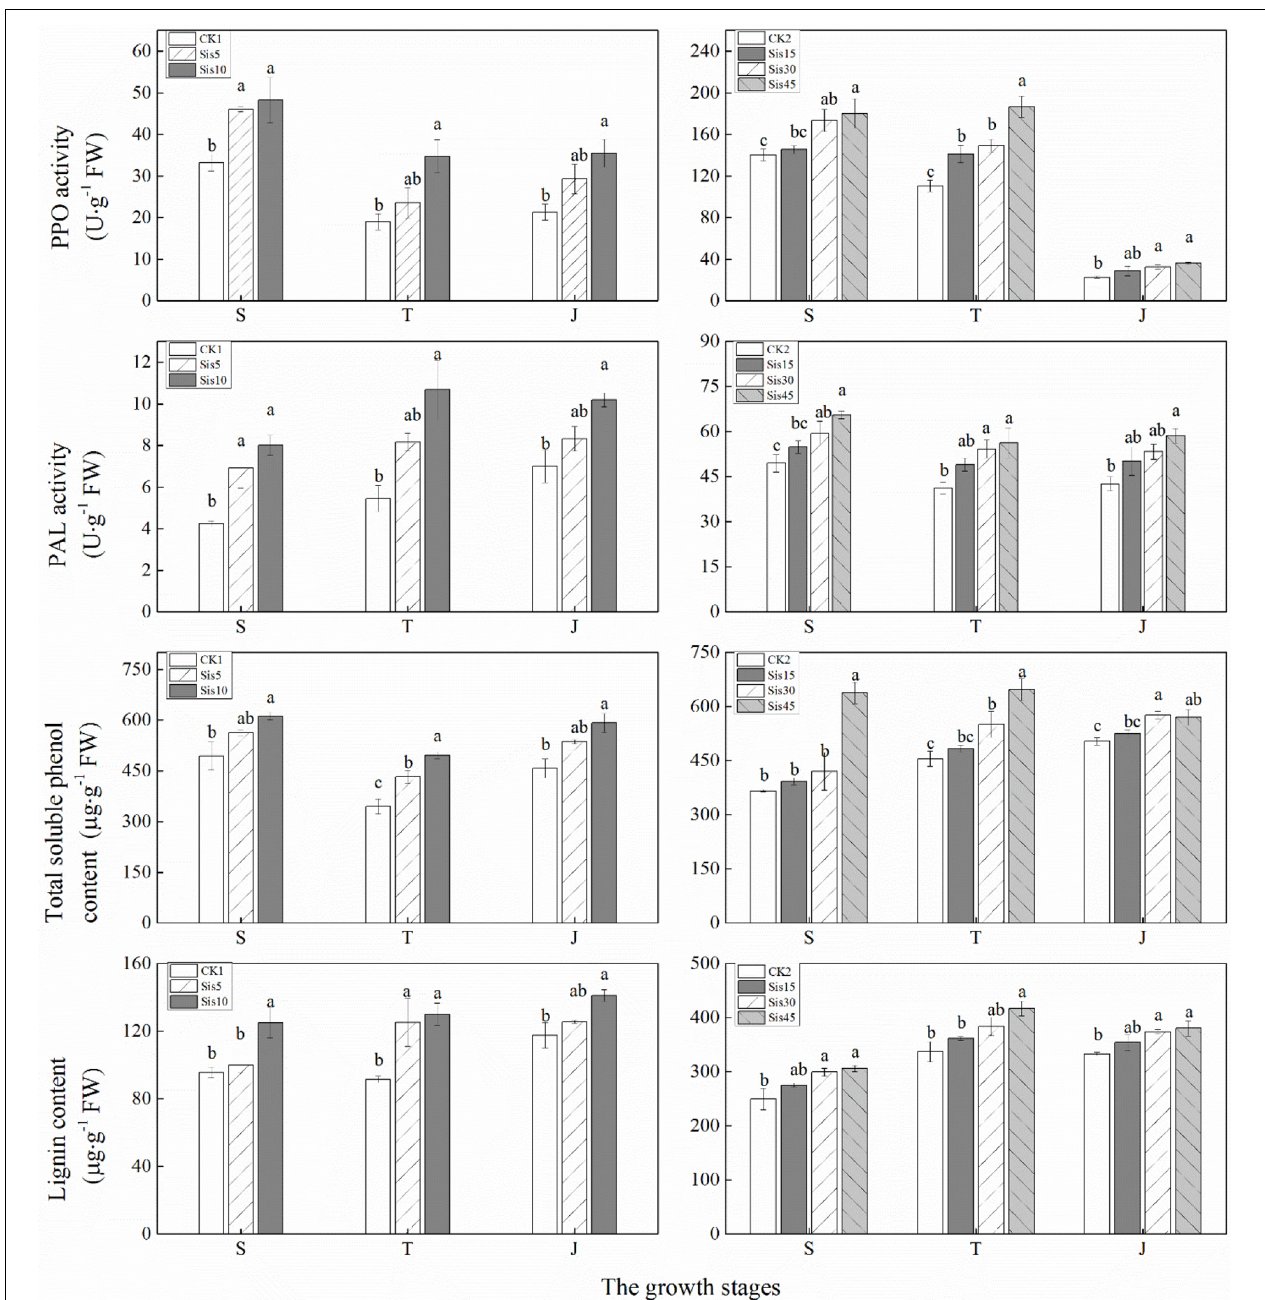
FIGURE 4 | Effects of silicon application on secondary metabolism-related enzymes activities [polyphenoloxidase (PPO) and phenylalanine-ammonia-lyase (PAL)] and the contents of secondary metabolites (total soluble phenol and lignin) in sugarcane leaves under Sporisorium scitamineum stress. Various lowercase letters represent significant differences at the P level of 0.05. S, seedling stage; T, tillering stage; J, jointing